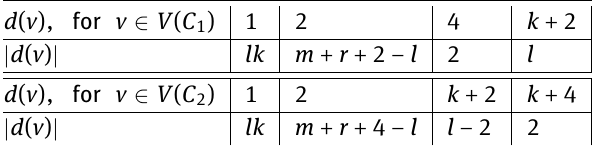
Table 3: Vertex-partitions of the tricyclic graphs C 1 and C 2 .